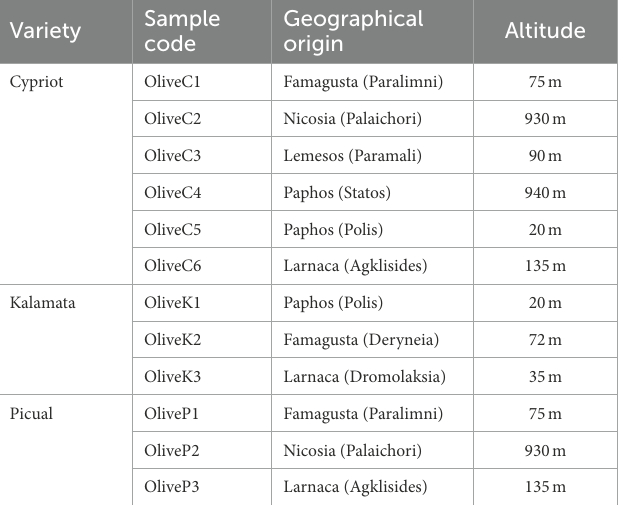
TABLE 1 Variety, sample code and geographical origin of fermented table olives.